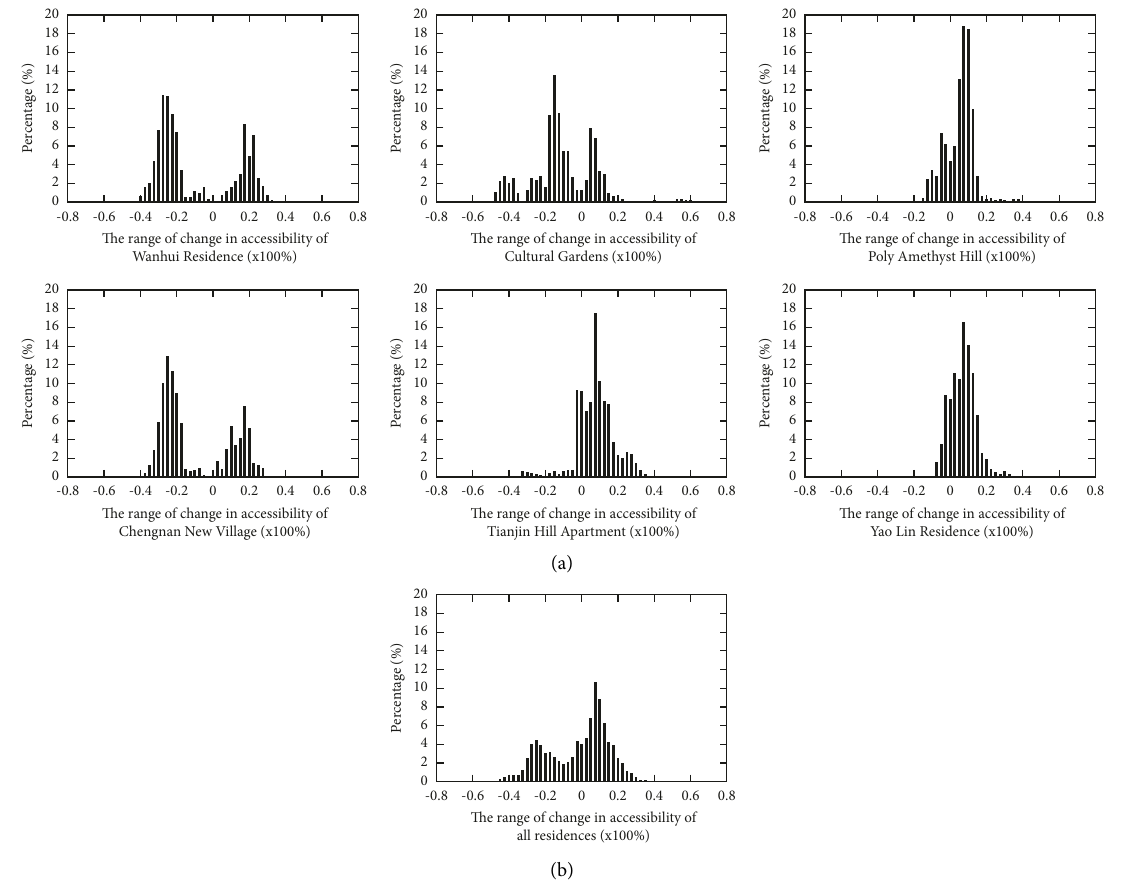
Figure 5: Frequency distribution of the rangeability in temporal accessibility for each residential area (a) and all residential areas (b). (a) Various residential communities. (b) All residential